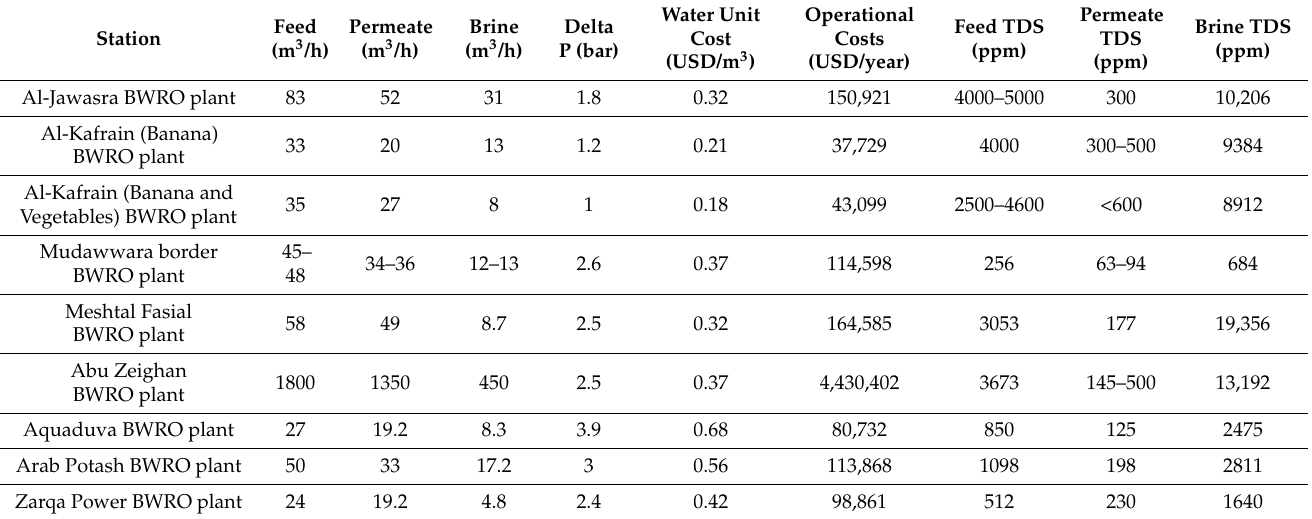
Table 3. Surveyed data for the assessment of BWRO desalination